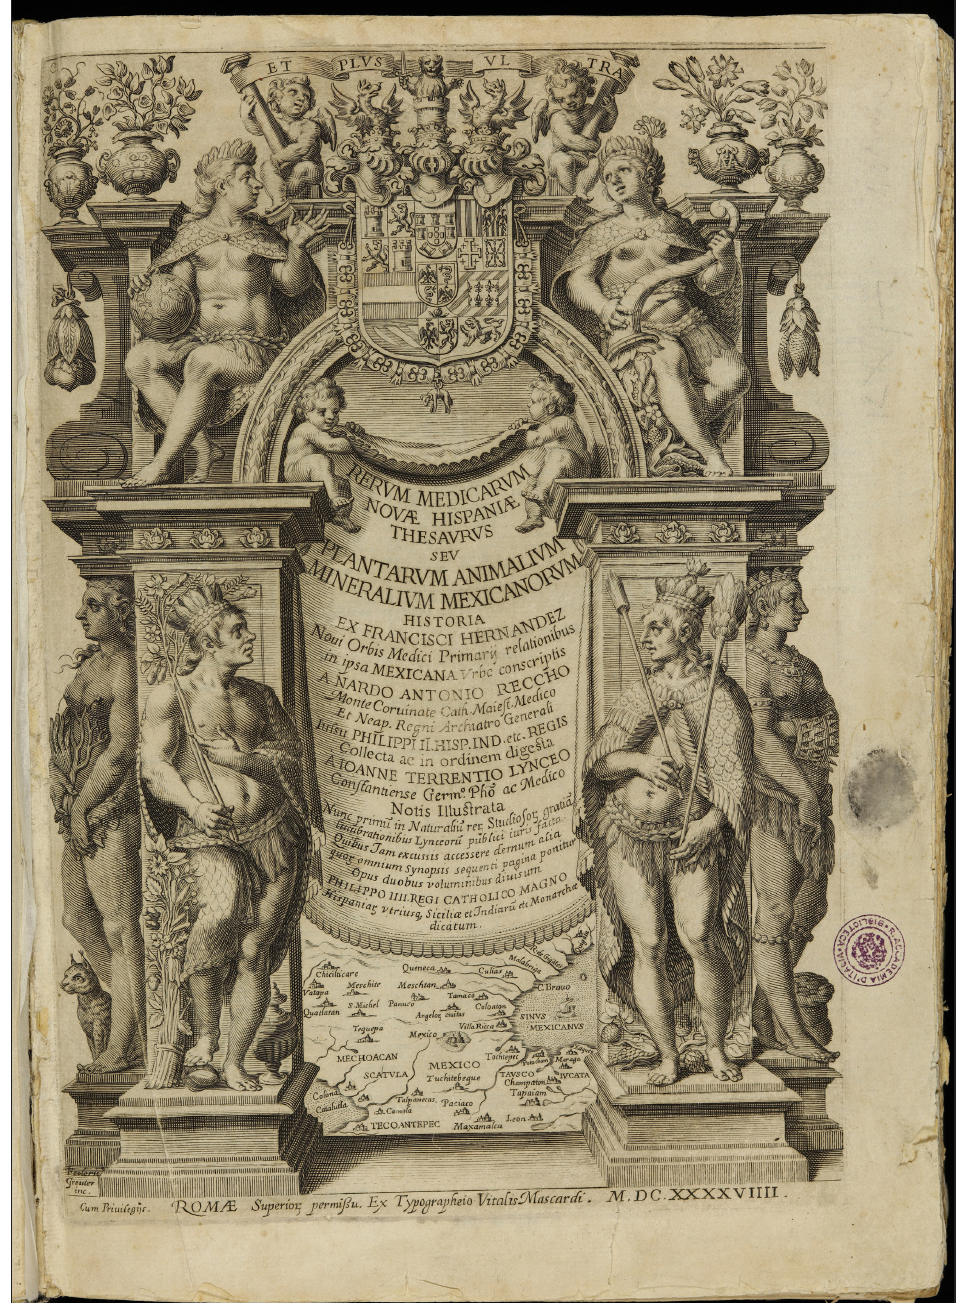
Figure 4: Matthäus and Johann Friedrich Greuter’s frontispiece to Hernández et al.’s Rerum medicarum 1648–1651 (by permission of the Accademia Nazionale dei